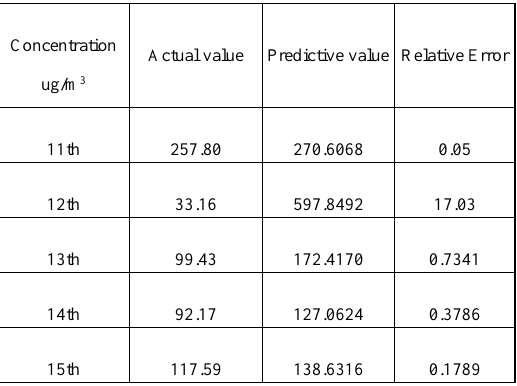
Table 5. Forecasts for the 11th to the 15th of